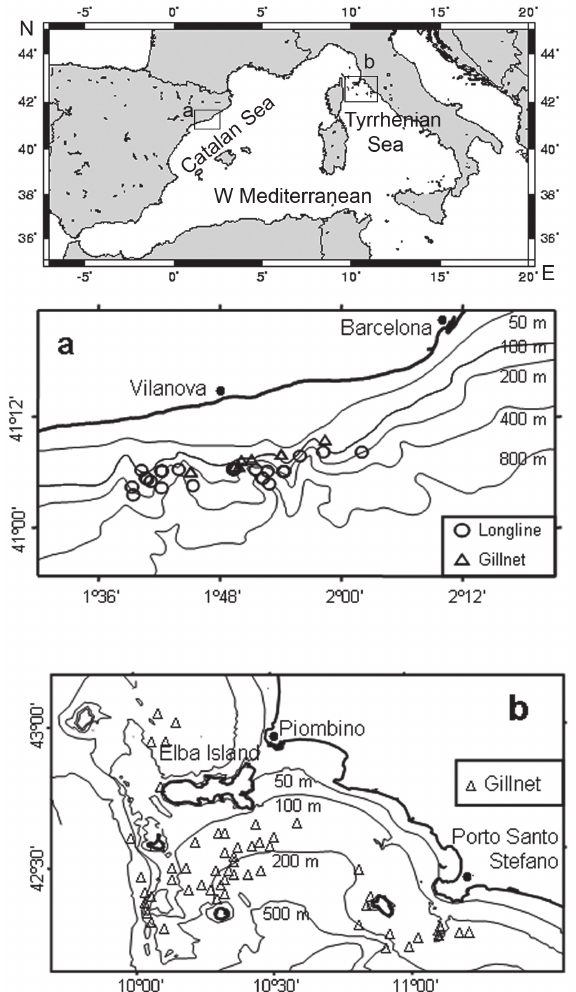
Fig . 1. – Geographical sampling location in western Mediterranean. a) Catalan Sea ( ö , Longline; Δ , Gillnet); b) northern Tyrrhenian Sea ( Δ , tude: the Catalan and northern Tyrrhenian seas (Fig.